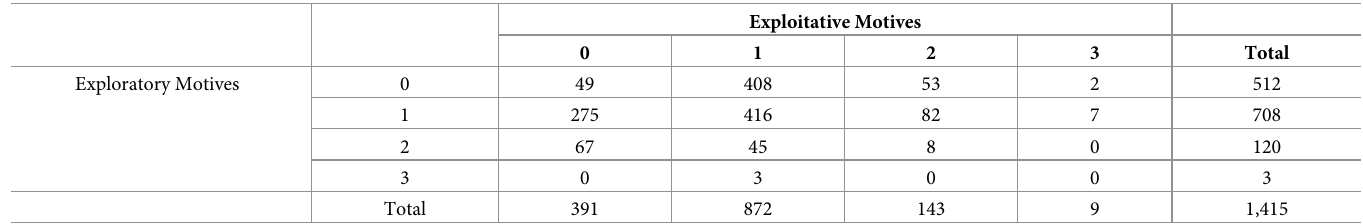
Table 1. Motives per